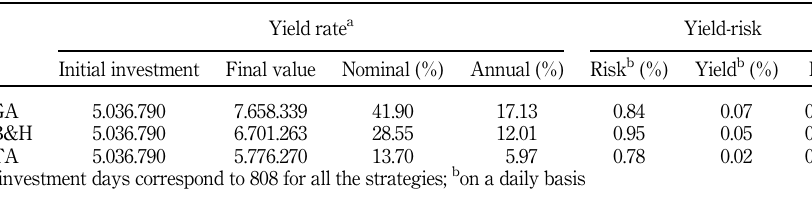
Table 3. Yield and yield-risk ratio of the strategies and parameter of the MACD